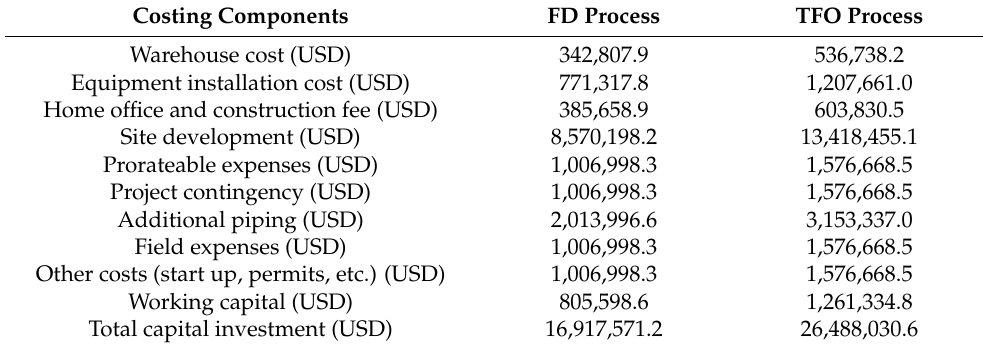
Table 6. Cost distribution for total operating cost for acrylic acid production via two pathways.